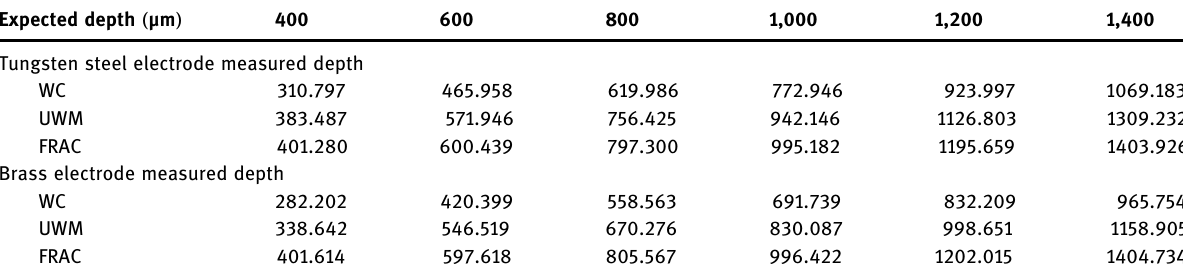
Table 3: The measured depth of the blind holes Expected depth ( µm )